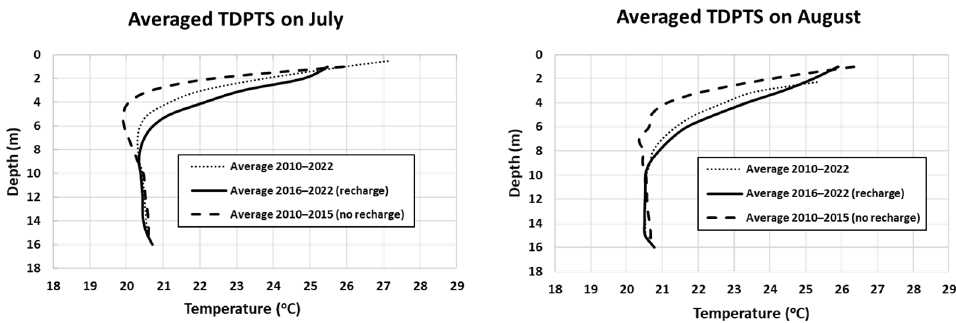
Figure 6. TDPTS averaged for years with and without recharge (2010–2015 and 2016–2022, respec- tively) in the months of July ( left ) and August ( right ).